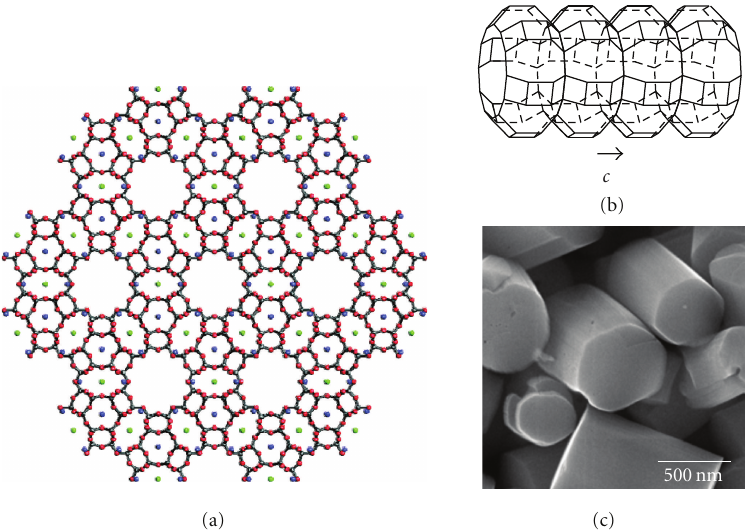
Figure 1: Zeolite L. (a) Top view of the structure of zeolite L illustrating its hexagonal framework. It shows a channel surrounded by six neighbouring channels. The centre-to-centre distance between two channels is 1.84 nm. (b) Side view of a channel that consists of 0.75 nm long unit cells with a Van der Waals opening of 0.71 nm at the smallest and 1.26 nm at the widest place. (c) SEM image of zeolite L